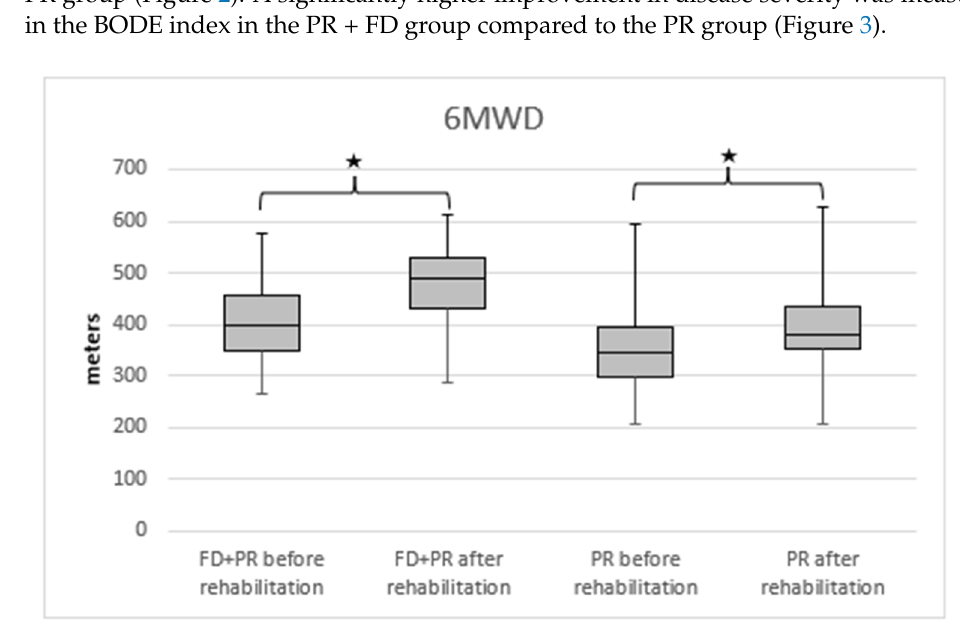
Figure 2. The change in 6MWD in PR and PR + FD groups in COPD; 6MWD: 6 min walking